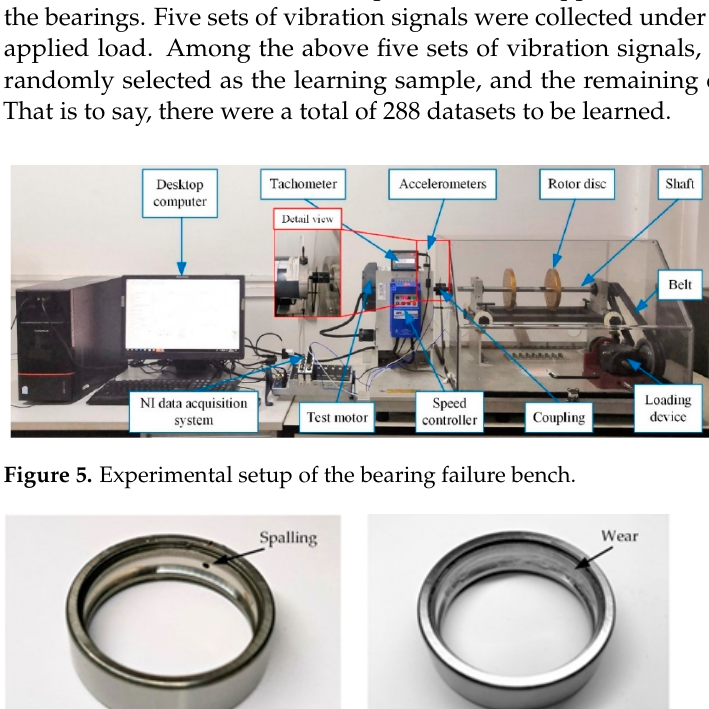
Figure 6. Simulated bearing failures; ( a ) spalling; ( b ) wear.